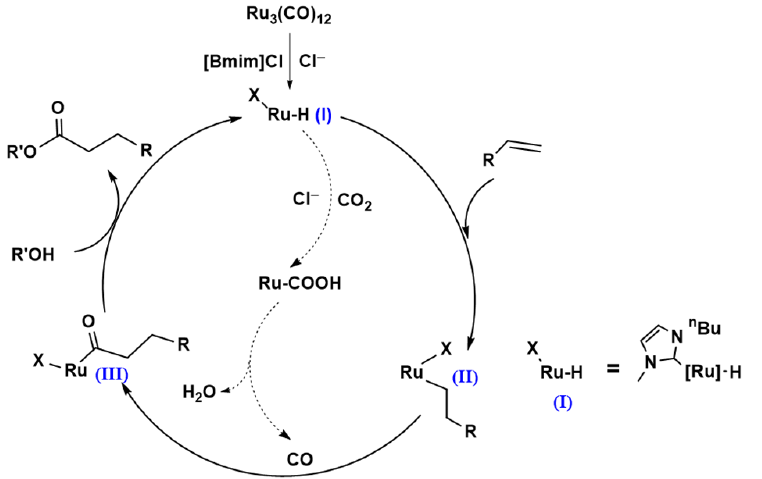
Table 3. Yield of MPA under different conditions on hydroesterification reaction a